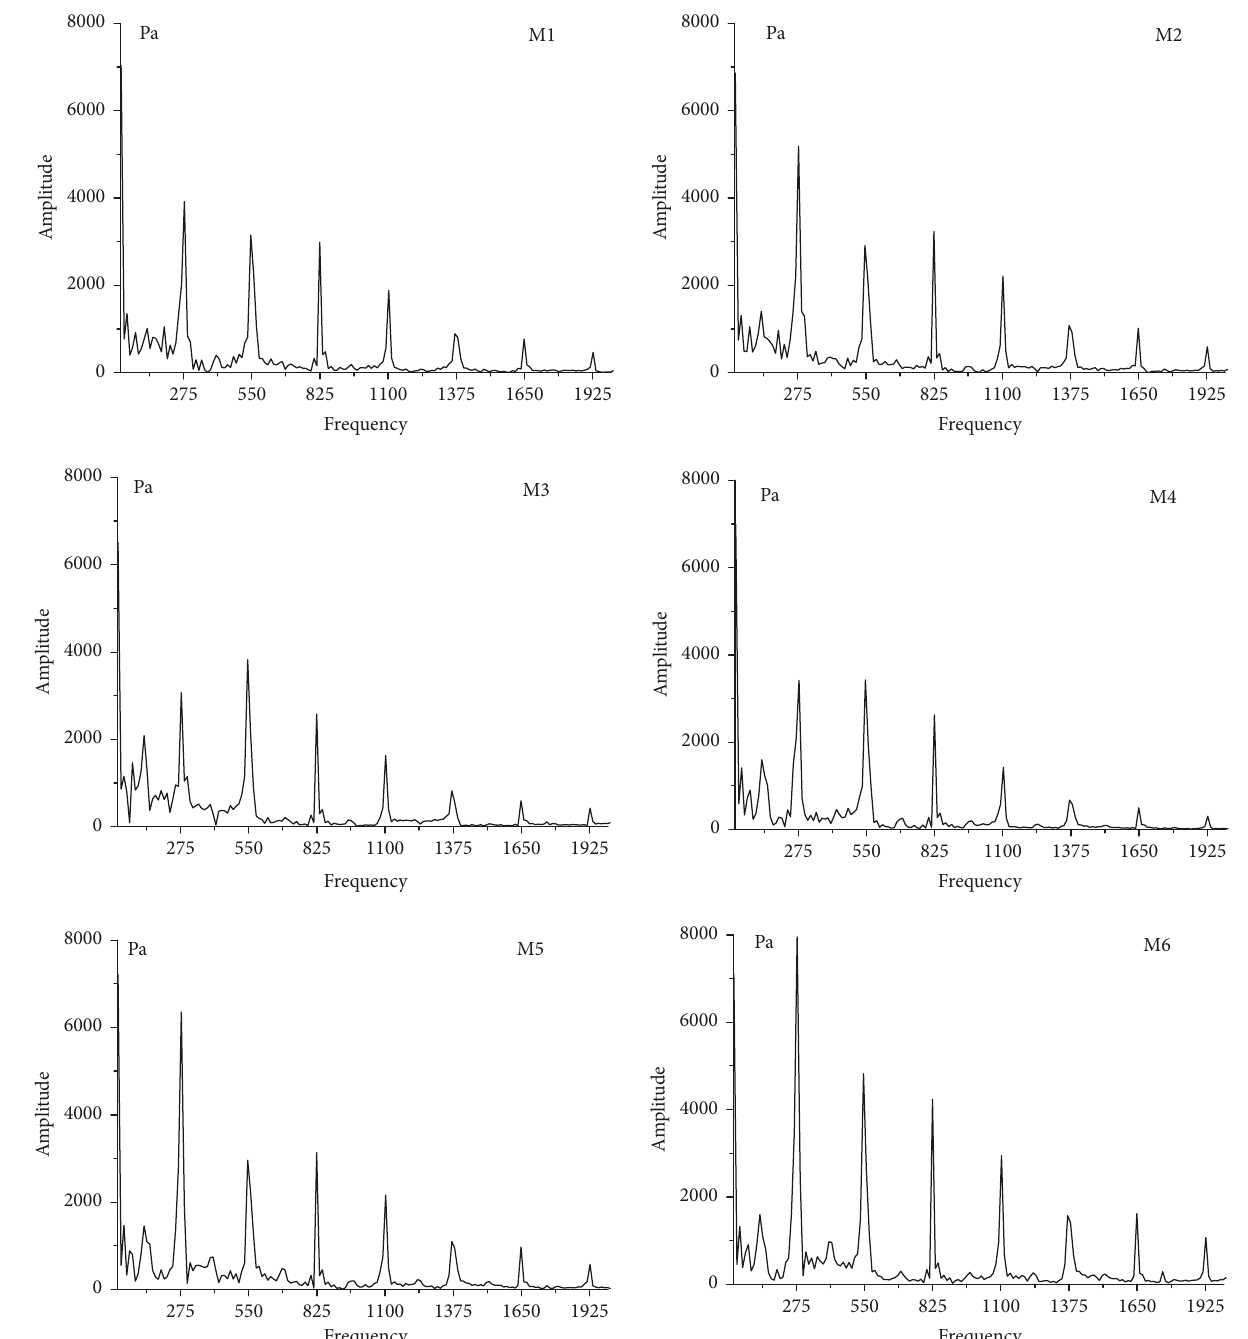
Figure 9: Frequency graph of monitors M1 ∼